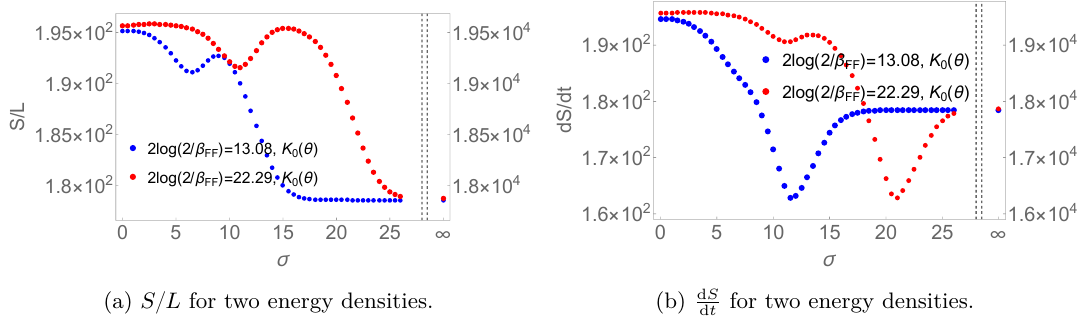
Figure 12 . The total entropy density S { L (a) and its production rate d S { d t (b) against σ after quenches characterised by K and fixed injected energy density. The blue dots correspond to 0 p θ q 2 log 2 { β 13 . 08 or β 2 . 8944 ˆ 10 ´ 3 (left axis) and the red dots to 2 log 2 { β FF “ FF “ β FF “ 2 . 8944 ˆ 10 ´ 5 (right axis).